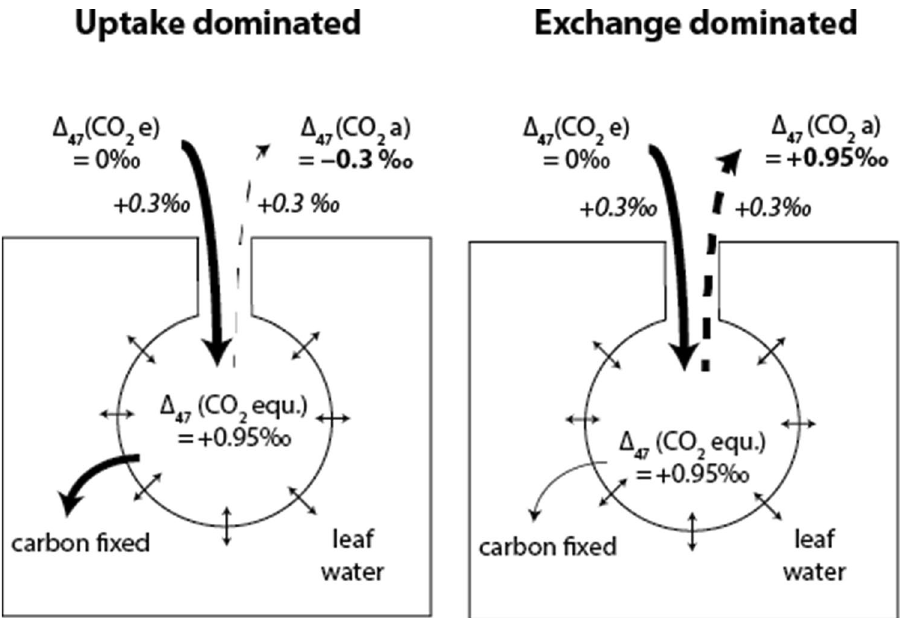
Figure 2. Schematic illustration of the clumped isotope fractionation during air-leaf gas exchange. Δ 47 of the CO 2 in the air surrounding the leaf is mainly controlled by CO 2 -H 2 O exchange and kinetic fractionation during diffusion into and out of the leaf stomata. In the uptake dominated case ( c m / c a ~ 0), − 0.3 ‰ comes from the fact that diffusion mediated leaf air interaction will reduce the Δ 47 value by 0.3 ‰, neglecting other effects. Diffusion only will reduce the Δ 47 value by 0.3 ‰ multiplied by the fraction of CO 2 entering the leaf that is assimilated 19 . The boundary layer conductance is large and we have omitted it